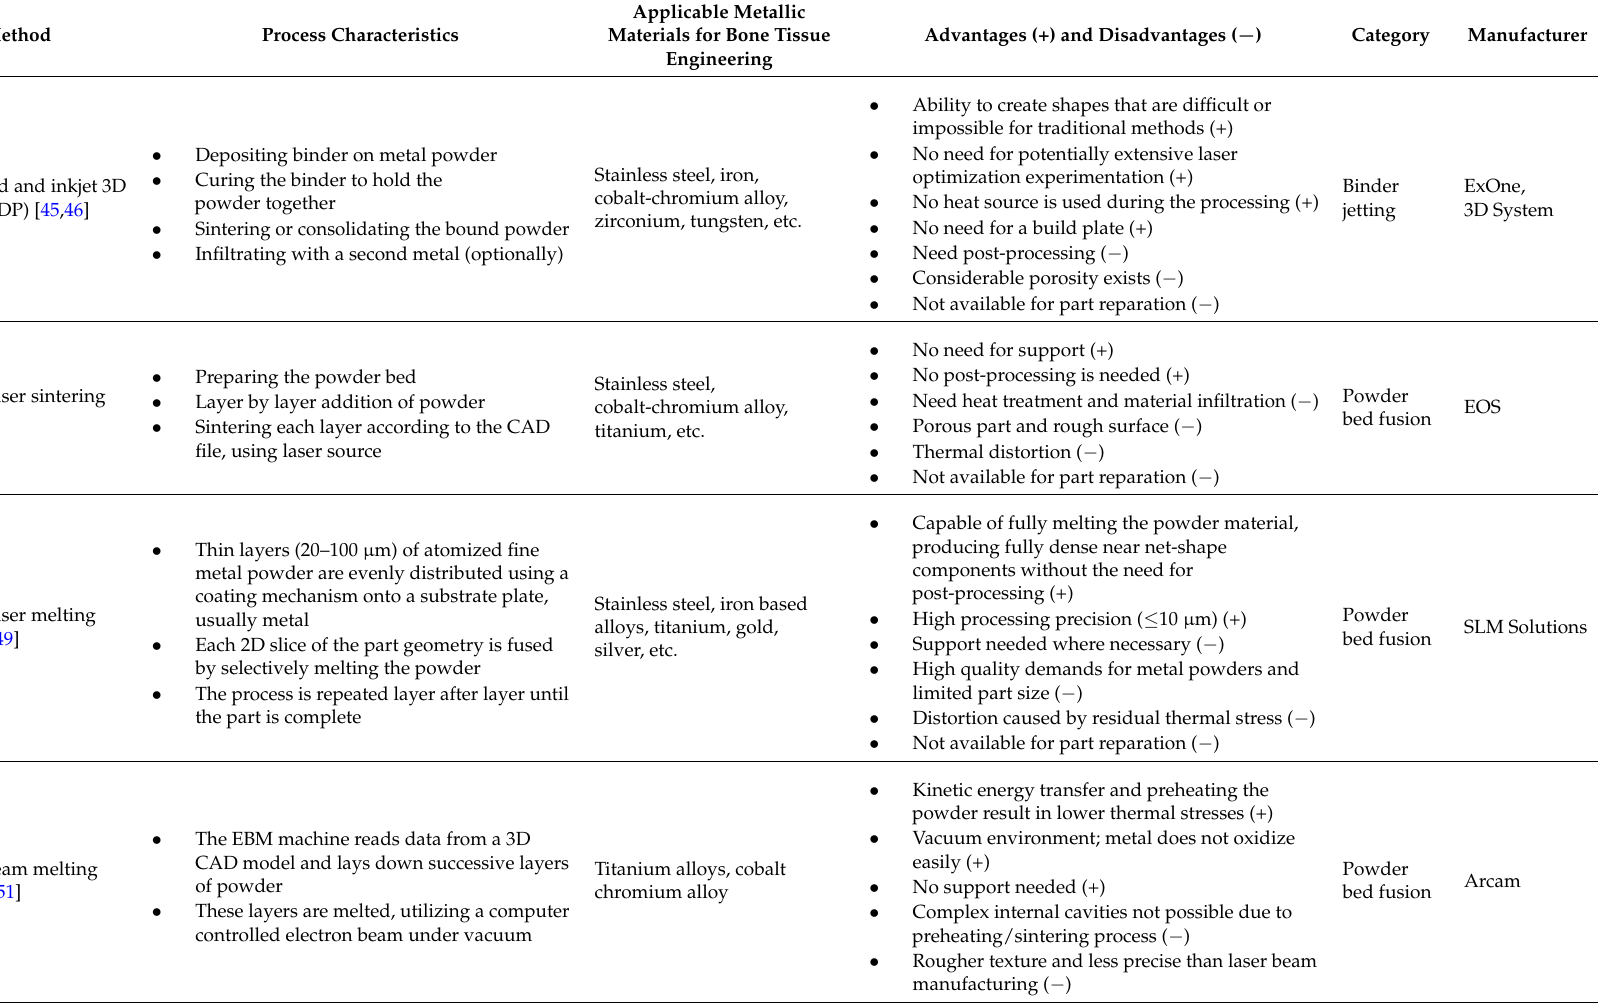
Table 1. Additive manufacturing (AM) technologies, their features and